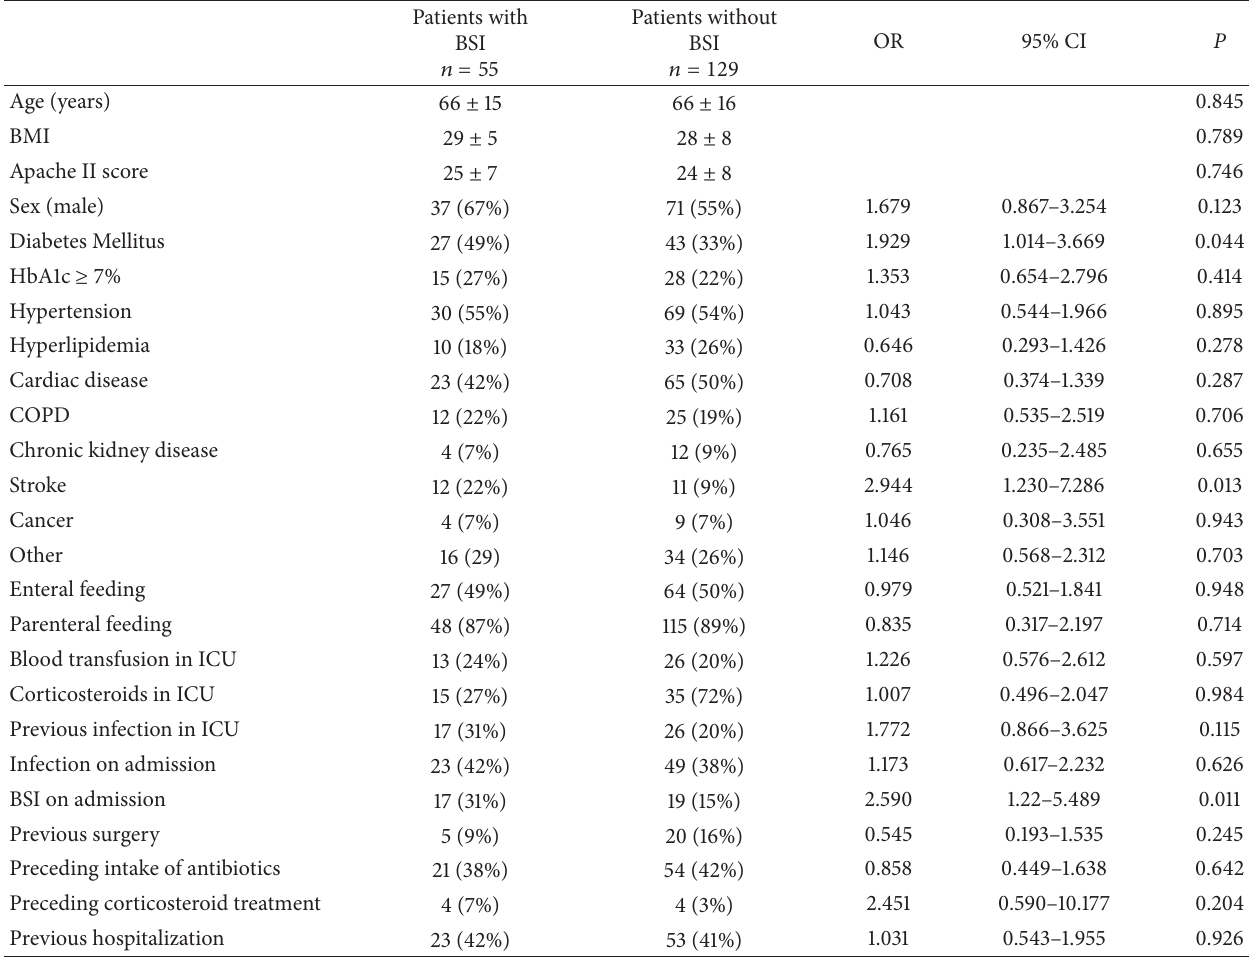
Table 5: Risk factors for bloodstream infections (BSI) Patients with